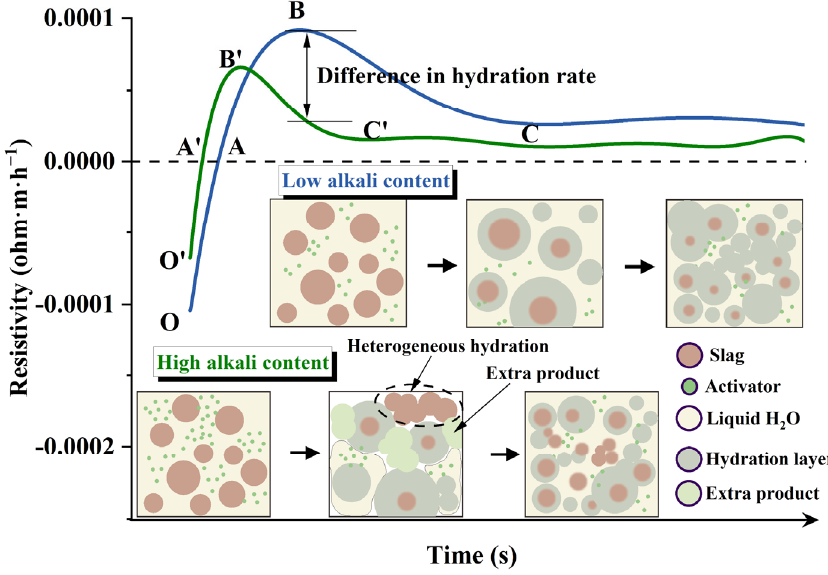
Figure 4. A simplified model of the effect of alkali content on resistivity development.